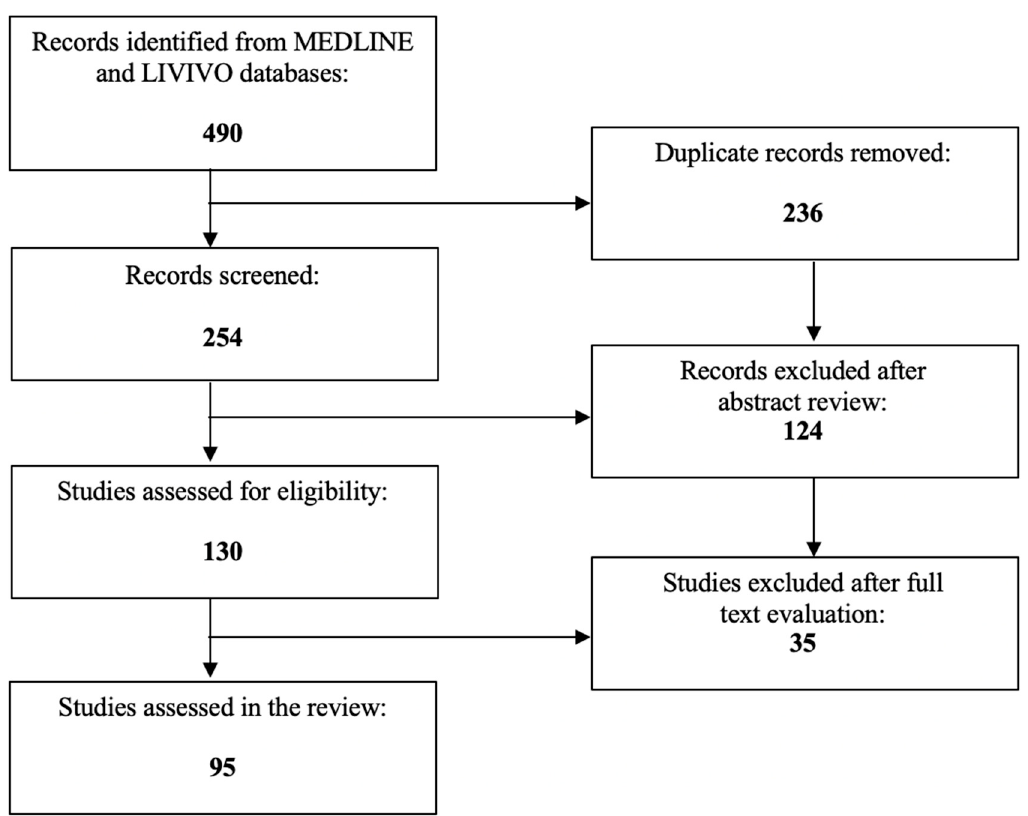
Figure 2. PRISMA flow diagram visually summarizing the screening process.